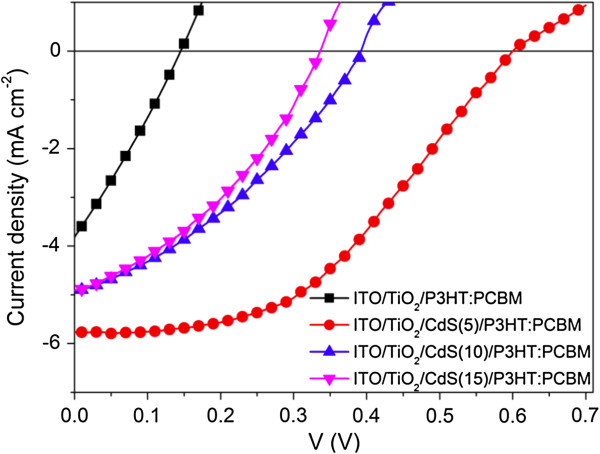
I-V characteristics of the ITO/nc-TiO2/CdS( n )/P3HT:PCBM devices (n = 0, 5, 10, and 15).